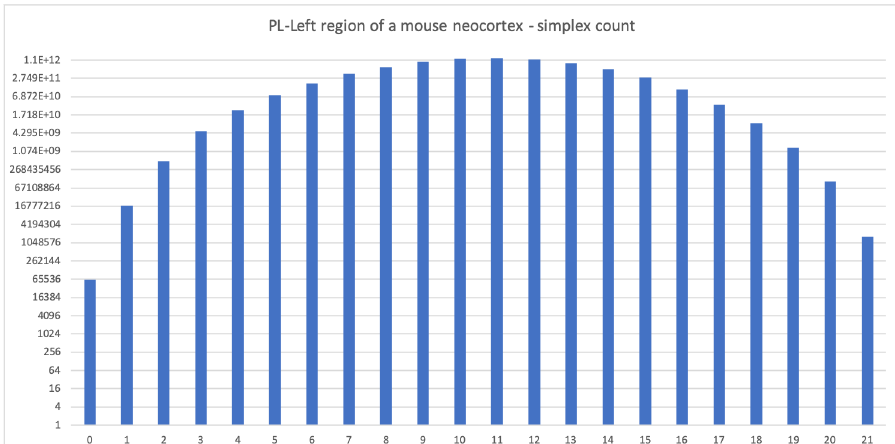
Figure 3. The simplex count for the PL-Left region of a mouse neocortex (local connections only). The complex is 21-dimensional with more than 1.2 trillion 11-dimensional simplices. Computation was run in parallel on two nodes of an HPC cluster with 256 CPUs each, required 1 GB of memory and took five days to complete (run as 10 different jobs of 24 h